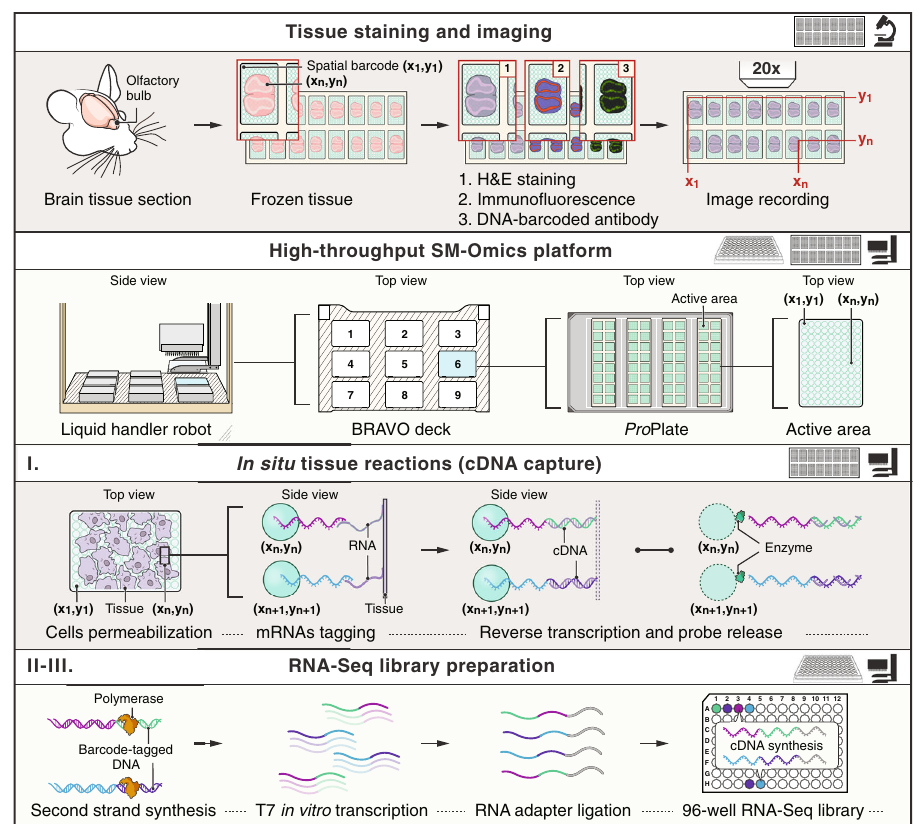
Fig. 1 SM-Omics. Overview of approach. SM-Omics approach combines automated imaging of H&E, IF stained or tissue sections stained with DNA- barcoded antibodies with high-throughput liquid handling to create spatially resolved RNA-Seq and/or antibody-seq libraries. The RNA-Seq protocol consists of three main steps. (I) in situ reactions on a ST slide that include tissue permeabilization, capture of mRNAs on the spatial array followed by a reverse transcription reaction in solution. The transcribed material is then collected and a two-step library preparation protocol (II – III) is run in standard 96- well (two-sided Wilcoxon ’ s rank-sum test, p -value > 0.05) between the